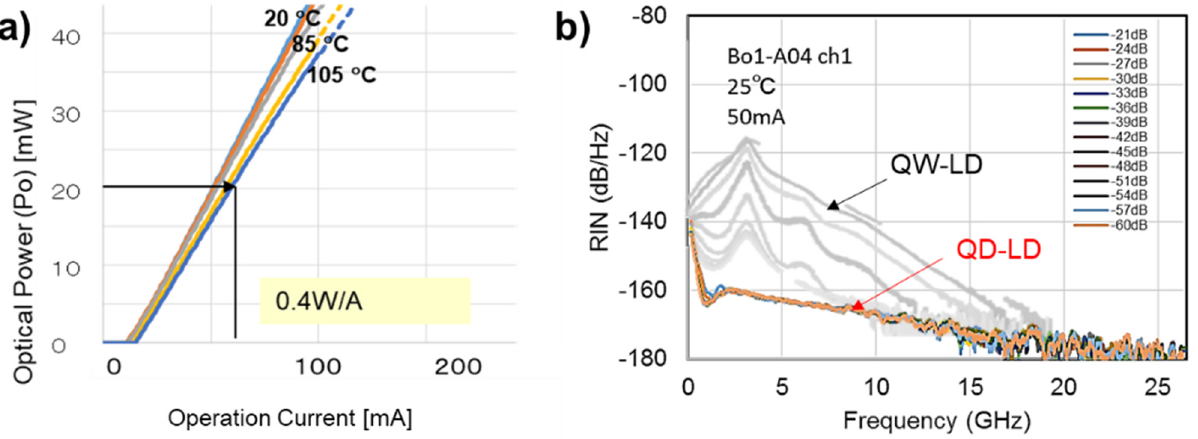
Figure 7. QD-LD performance: ( a ) L-I characteristics of QD-LD at different temperatures; ( b ) RIN for back reflection .